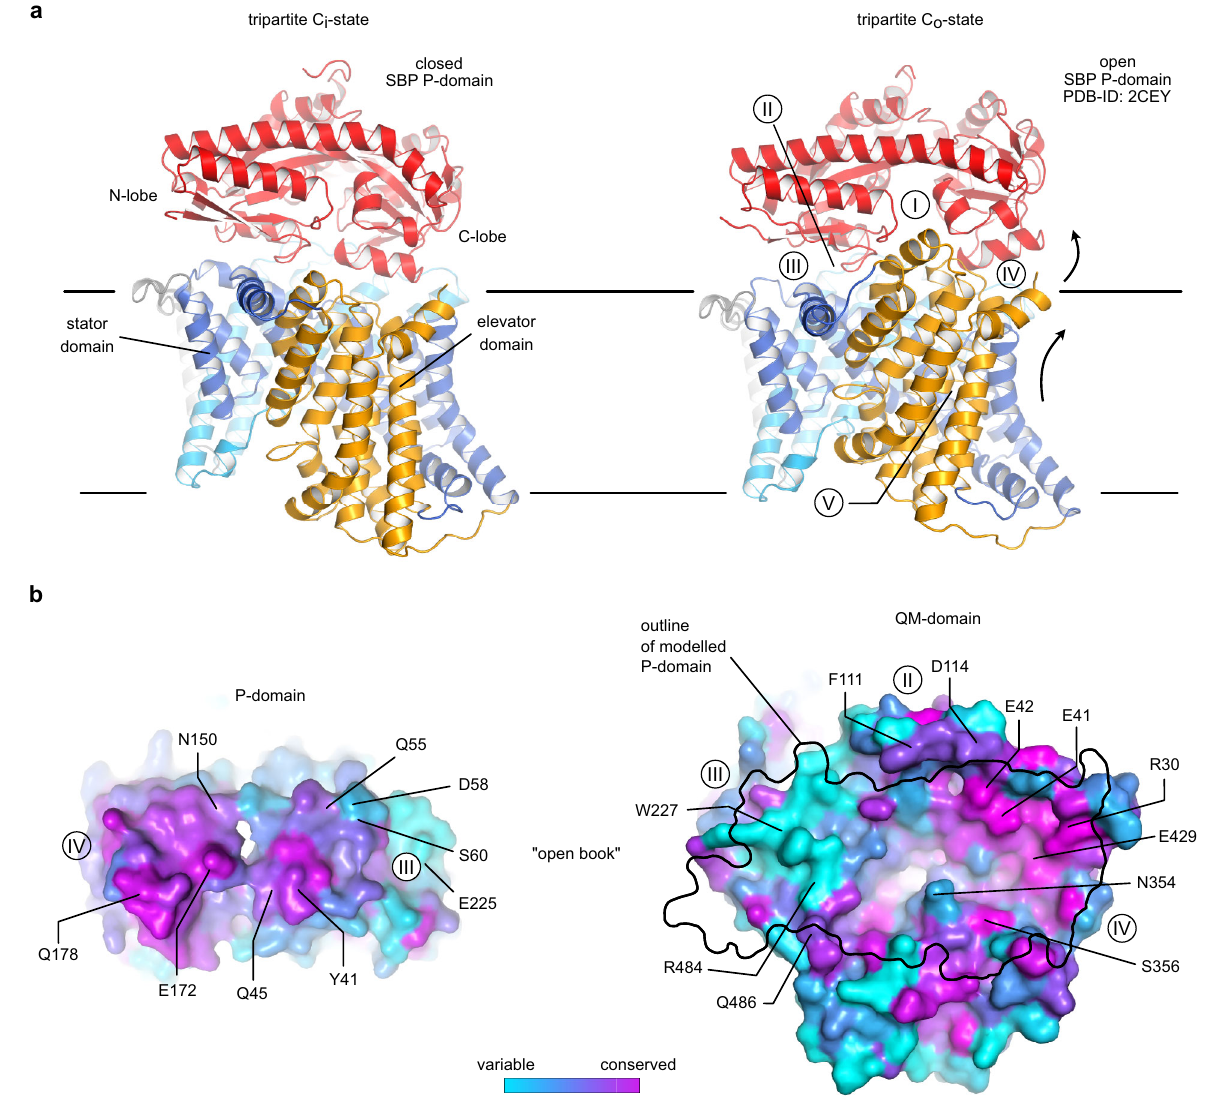
Fig. 4 Constructing the tripartite PQM complex. a Left: AlphaFold model of the tripartite complex between HiSiaQM and HiSiaP in the C i state. Right: The outward open model of HiSiaQM (C o state, Fig. 2d). Here, the P-domain was replaced by the open (substrate-free) structure of HiSiaP (2CEY) by aligning it onto the N-terminal lobe of the P-domain in the C i state (left). b “ Open book ” view of the interface regions between QM and the N- (III) and C-lobe (IV) of the P-domain. The color code corresponds to the conservation of residues, calculated by Consurf 85 . The highlighted residues are in regions I – V that are likely important for complex formation and were analyzed in the growth assay in Fig.